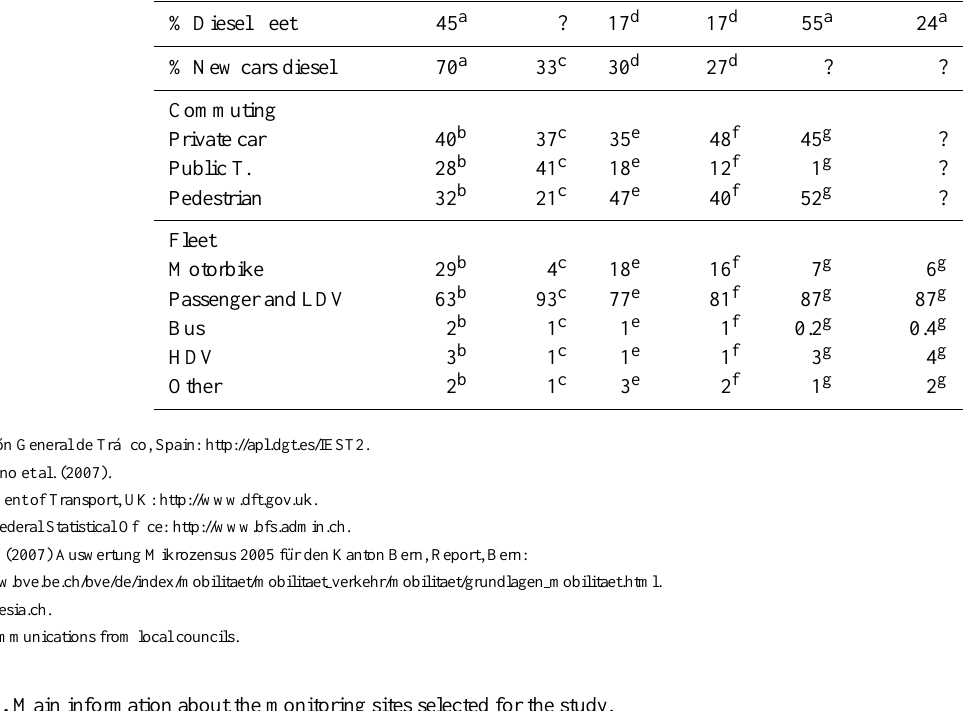
Table 2. Main information about the monitoring sites selected for the